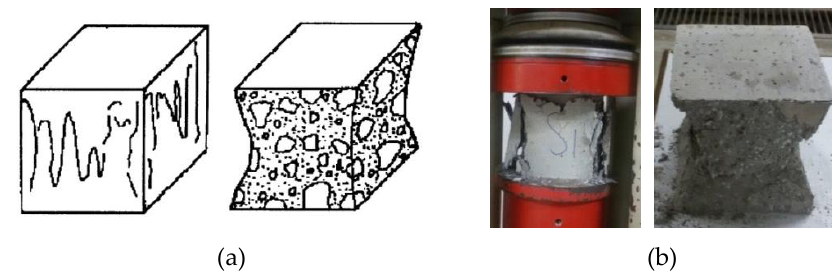
Figure 4. Comparison of failure modes between ( a ) British standard and ( b ) static test results.